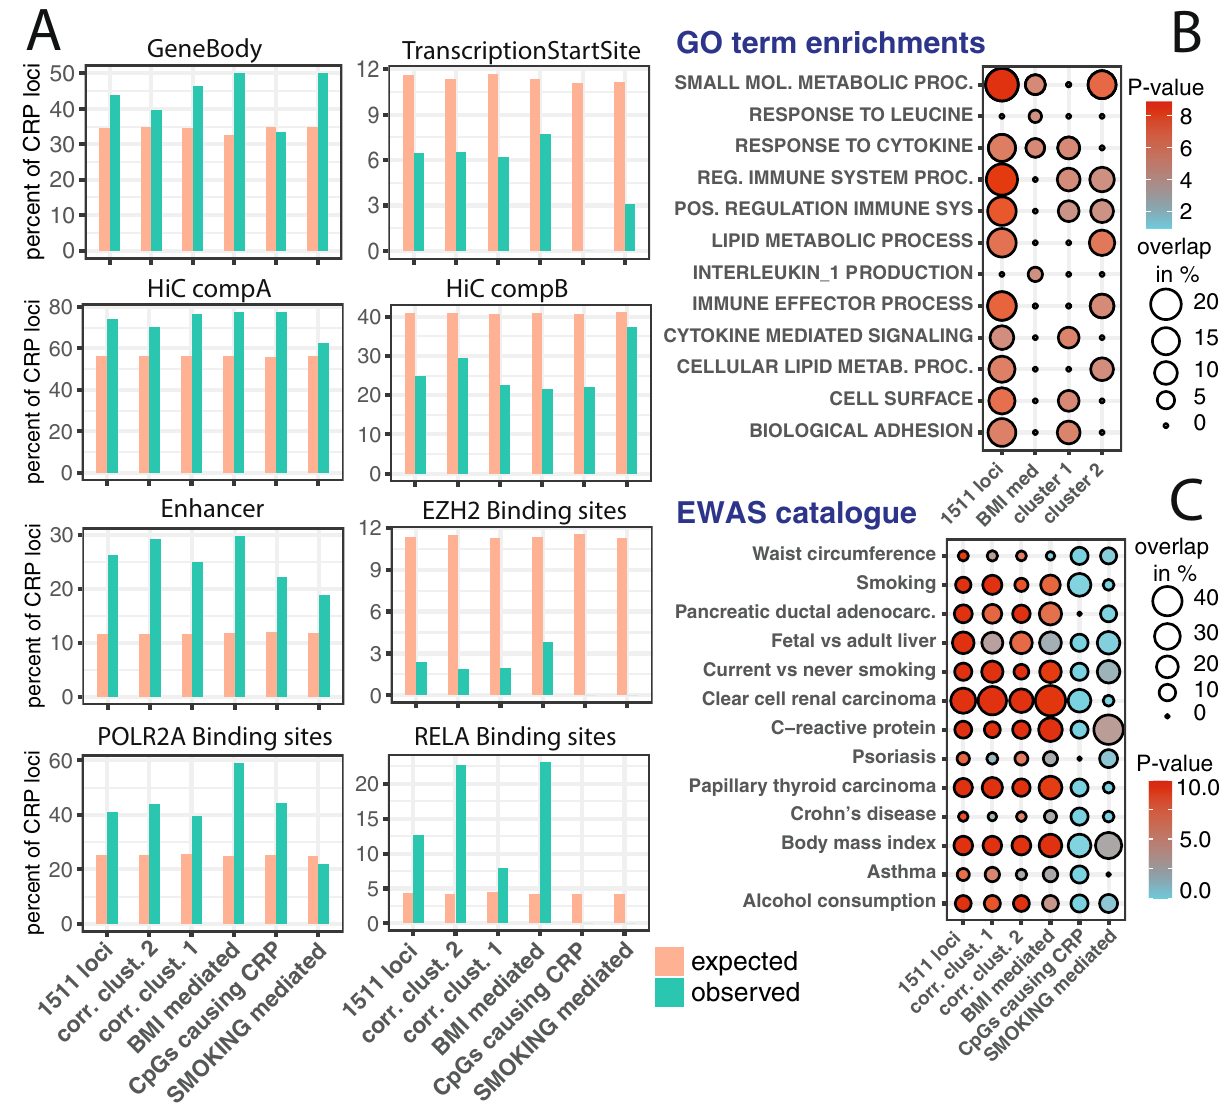
Fig. 4 Overrepresentation analysis. Panel A gives the percentage of each CRP-associated gene set that overlaps with selected genomic feature. Orange bars represent overlapping features by chance; green bars give the percentage that actually overlap with the CRP-associated CpGs. Transcription start site and enhancer genomic region were used as de fi ned by the Roadmap project. HiC regions were as reported in GSE63525, where component A was connected to highly transcribed genomic regions and component B to heterochromatin. Panel B shows enrichment analysis between CRP-associated CpG that were signi fi cantly associated with mRNA expression. Empirical P -values for the overlap derived from a permutation test (described in more detail in method section “ Overrepresentation analysis ” ) are given as negative log10. Percent overlap indicates the percentage of CpGs present in each GO term set. Panel C gives overlaps between CpGs observed in this study and published gene lists from large scale